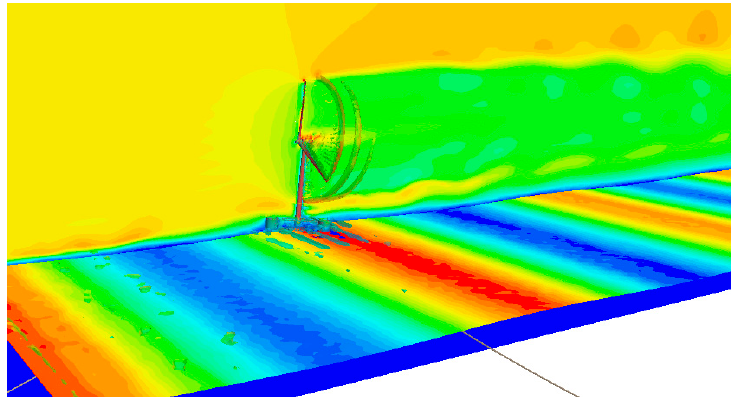
Figure 13. Velocity scene and water elevation.